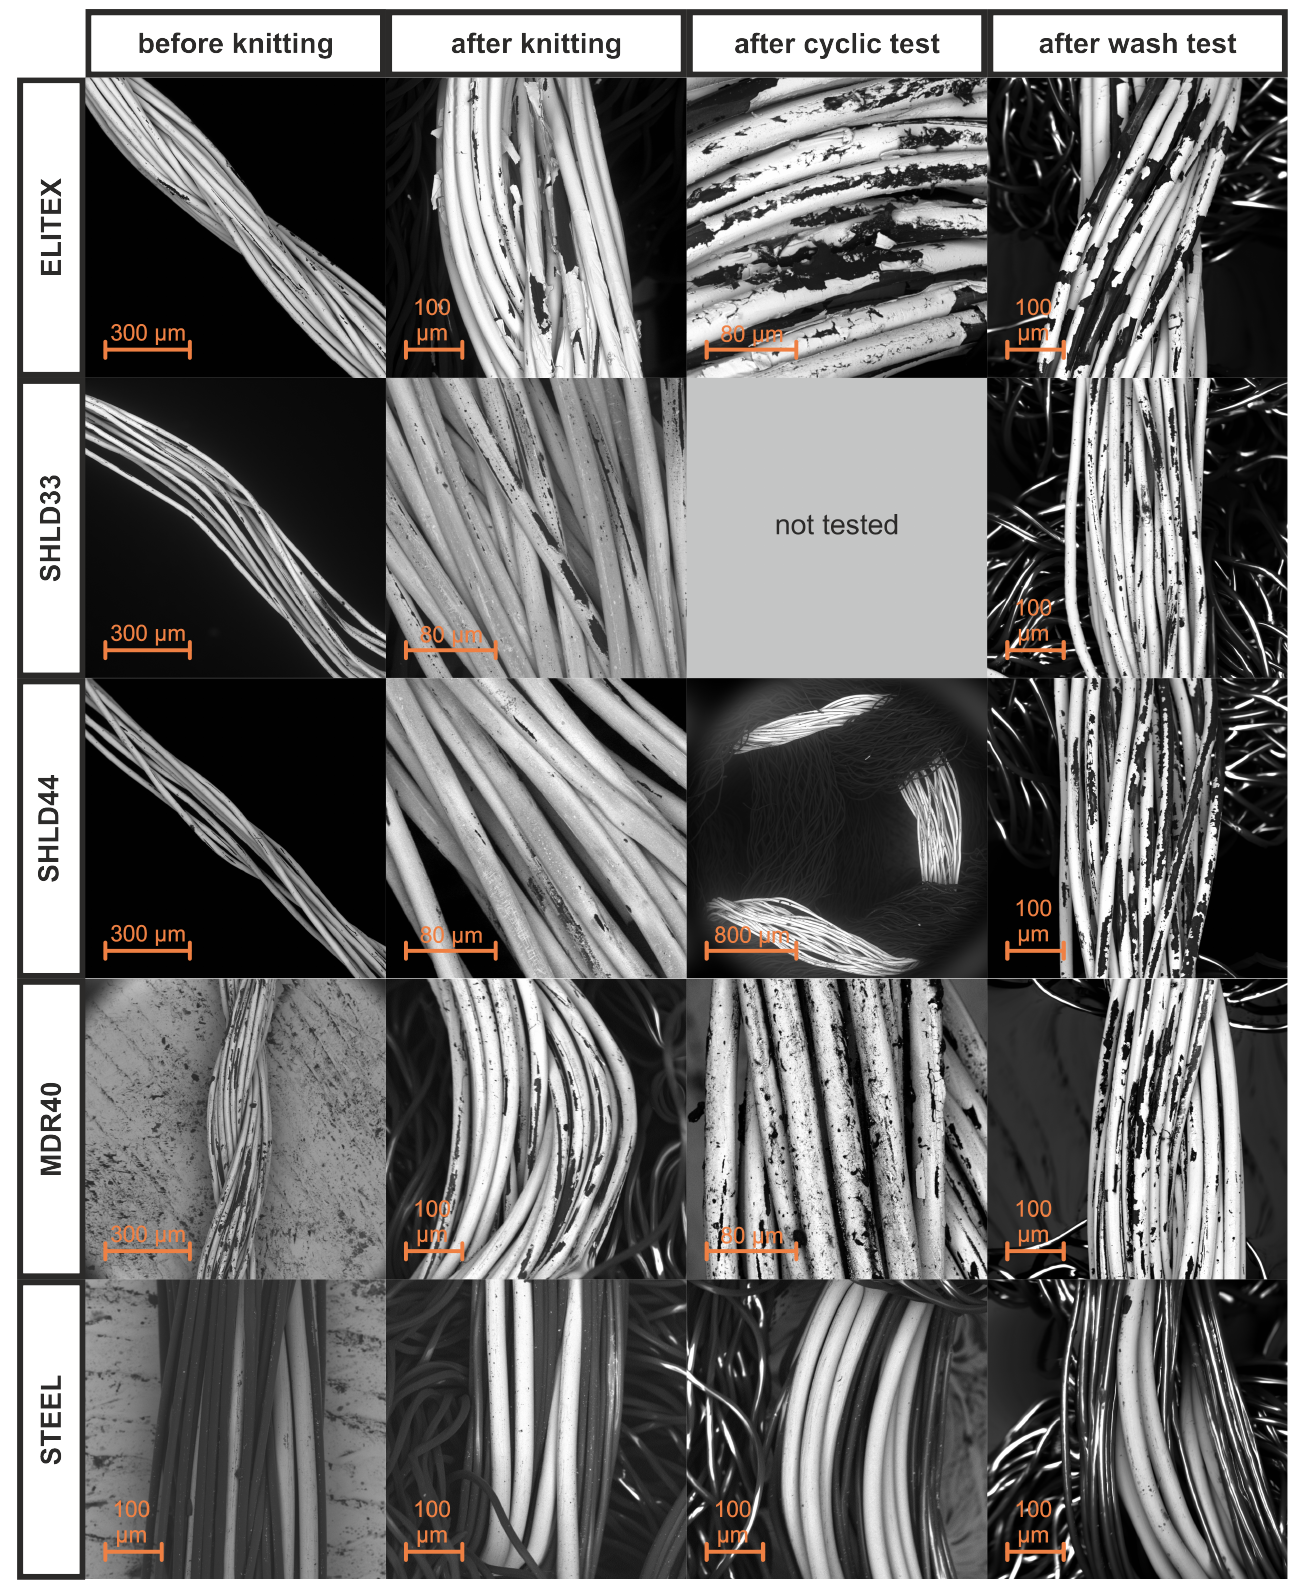
Figure 10. SEM damage analysis of the five conductive yarns before and after knitting and after cyclic and wash testing for SJ (cyclic testing was not done with SHLD33